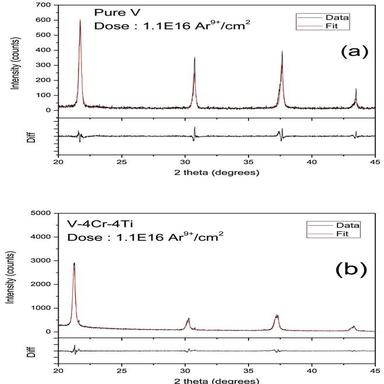
Typical MAUD fit of the XRD data for (a) Pure V and (b) V-4Cr-4Ti samples.